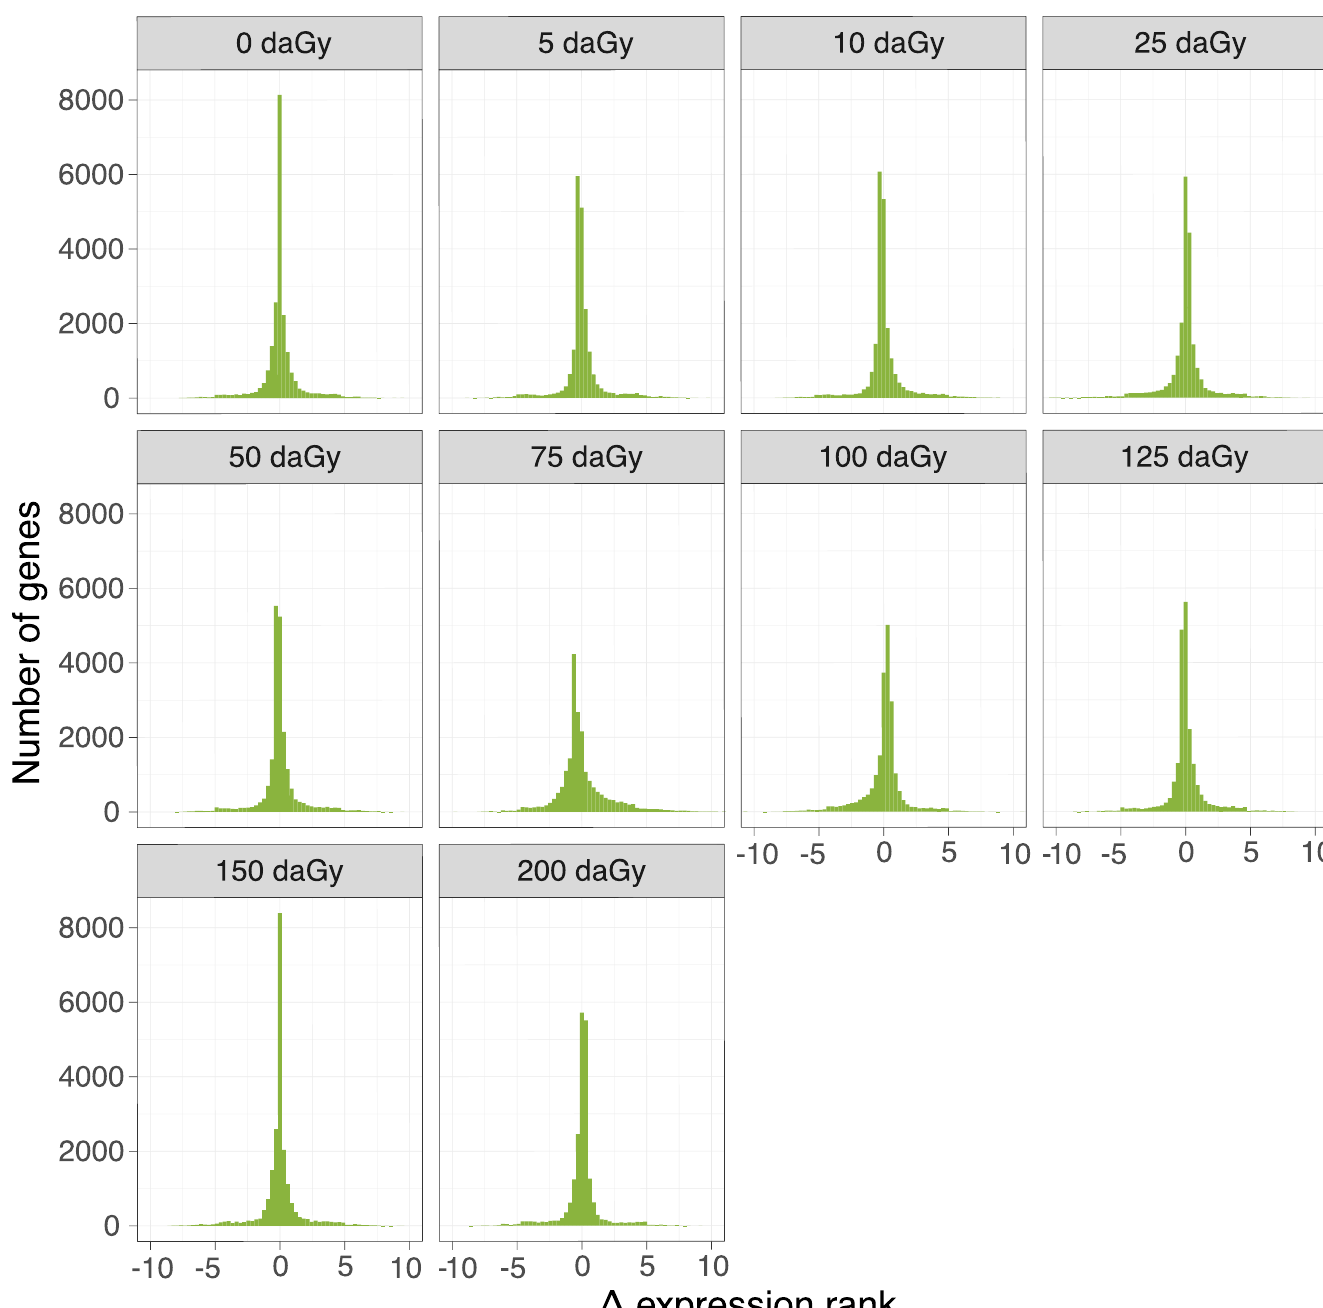
Fig 1. Comparison of the global genomic effects of proton and gamma radiation. Frequency distributions of the difference between expression ranks between proton and gamma radiation were plotted at each physical dose.